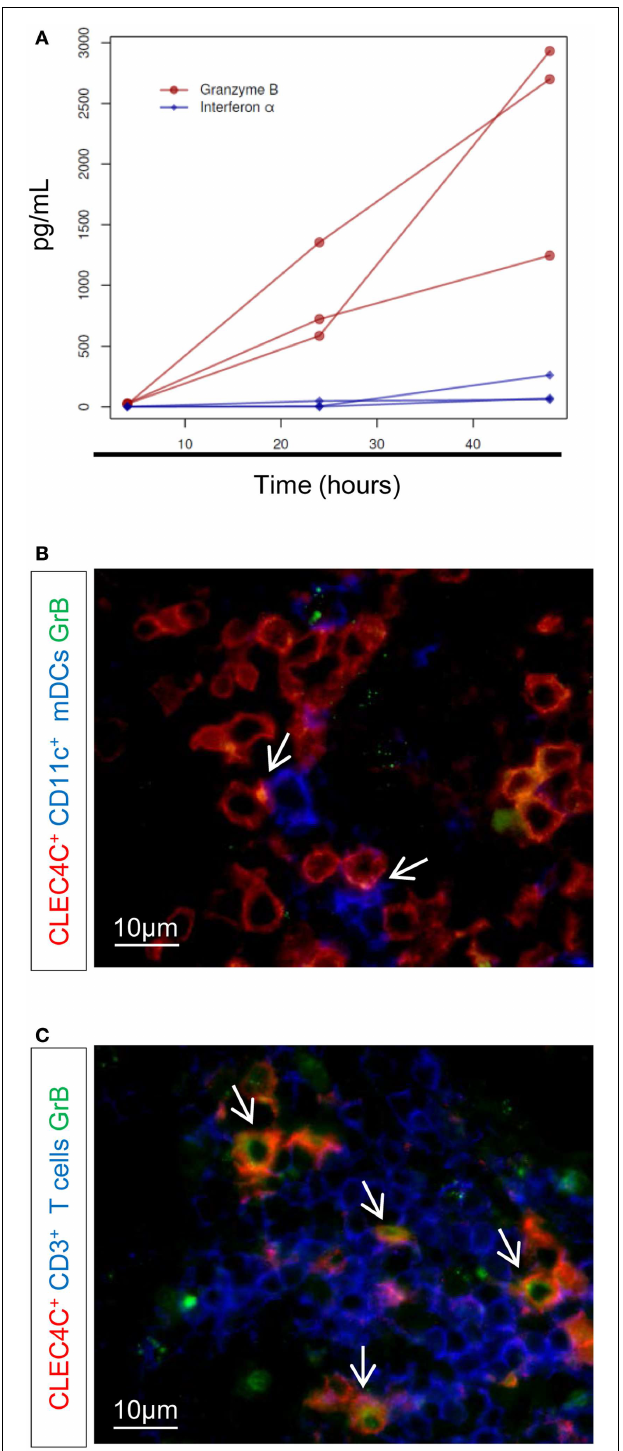
FIGURE 3 | Production of IFN- α and GrB after Mtb infection . (A) ELISA of IFN- α (blue diamonds) and granzyme B (GrB) (red circles), at 4, 24, and 48h after infection with Mtb. Only results from Mtb-infected CD1 + –pDC